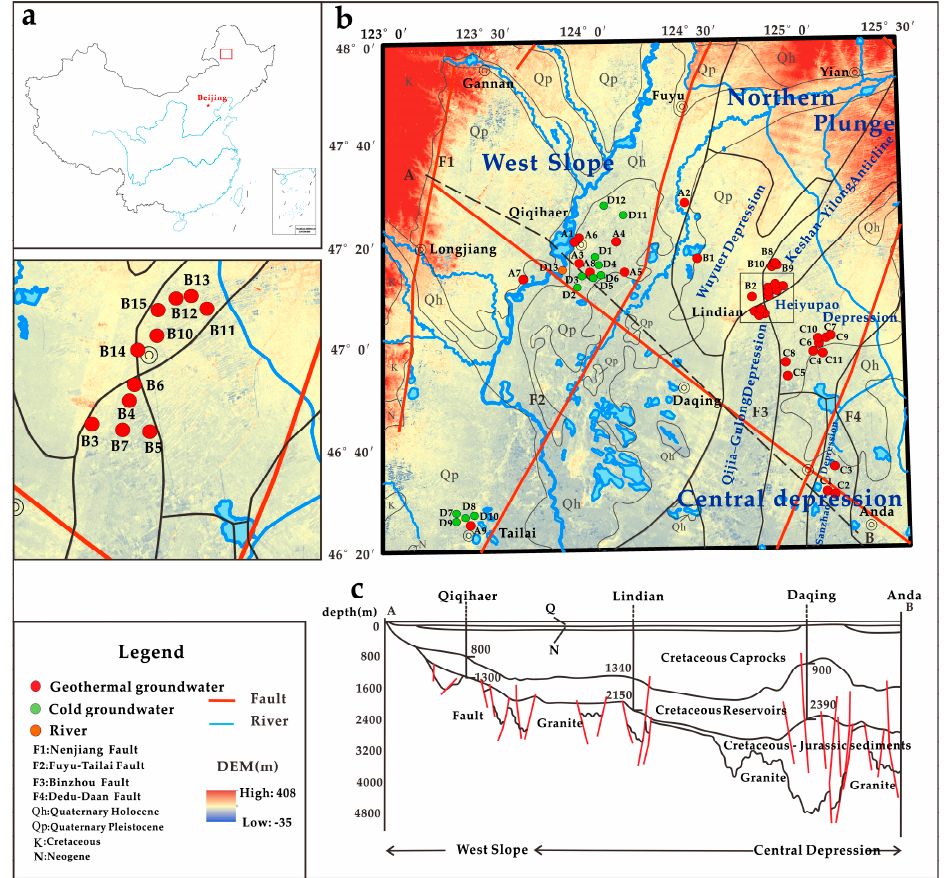
Figure 1. ( a ) Location of the area in China; ( b ) geological map and sampling sites; ( c ) schematic geological cross section of study area [31]. geological cross section of study area